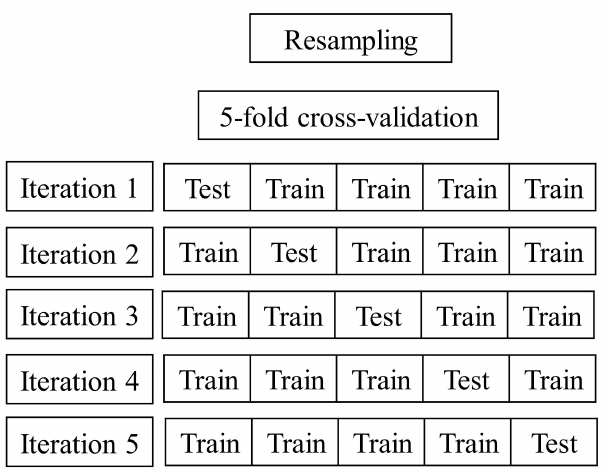
Figure 2. The resampling method used: five-fold